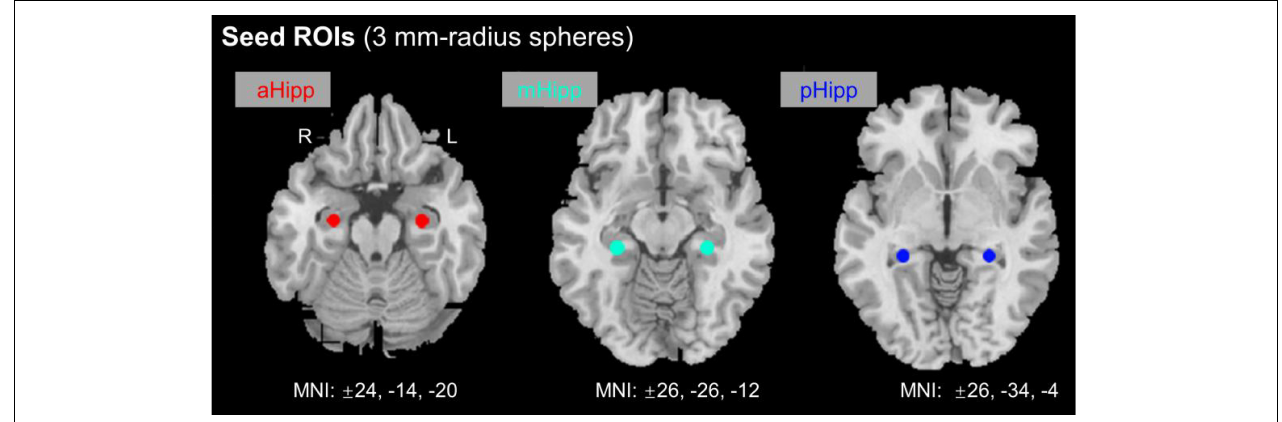
FIGURE 1 | Location of nodes along the anterior and posterior axes of the hippocampus. aHipp, anterior hippocampus; mHipp, middle hippocampus; pHipp, posterior